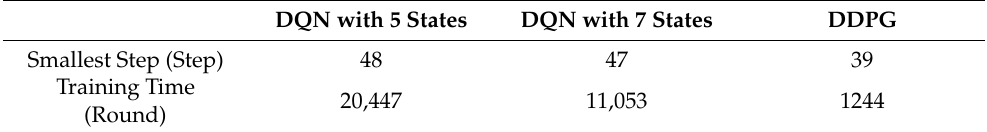
Table 3. The statistics for the second scenario, including the smallest number of steps to reach the goal and the training time required to find the smallest number of steps for reaching the